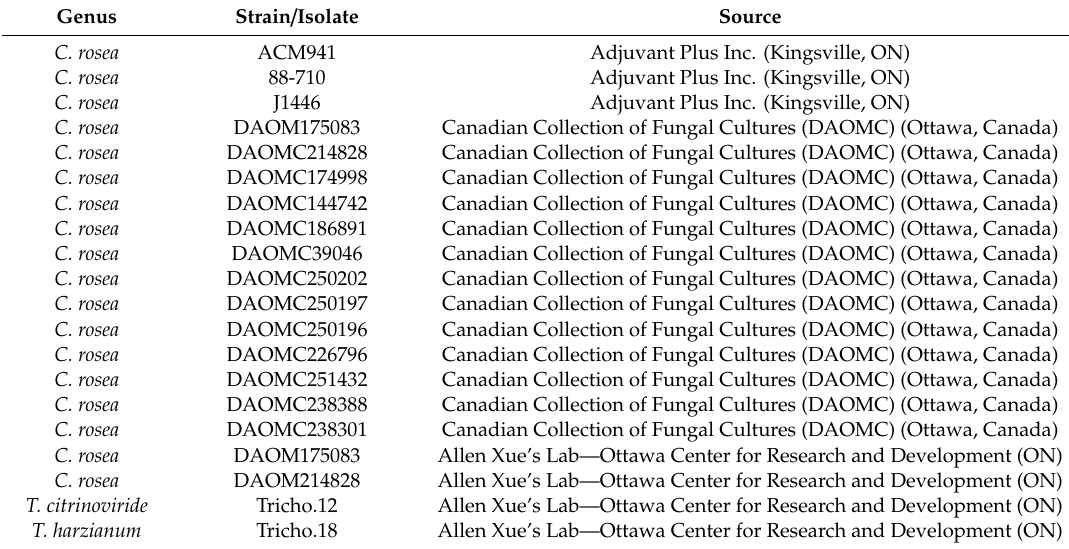
Table 1. Fungal strains used in this